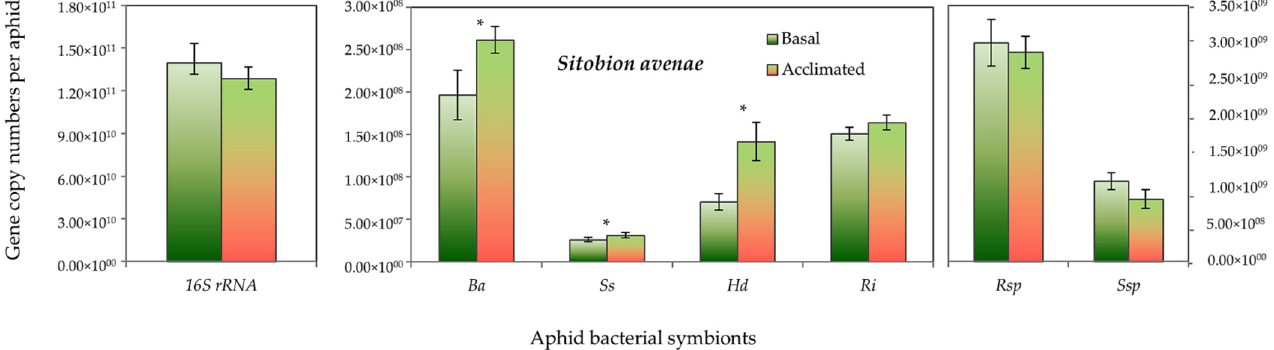
Figure 6. Abundance (mean gene copy numbers ± SD; n = 99) of bacterial symbionts of Sitobion avenae aphids in acclimated and basal treatments. 16S rRNA = total eubacterial r DNA gene; Ba = Buchnera aphidicola ; Ss = Serratia symbiotica ; Hd = Hamiltonella defensa ; Ri = Regiella insecticola ; Rsp = Rickettsia spp.; Ssp = Spiroplasma spp. Asterisks signify significant difference between acclimated and basal treatments (Student’s paired t -test; p ≤ 0.05).